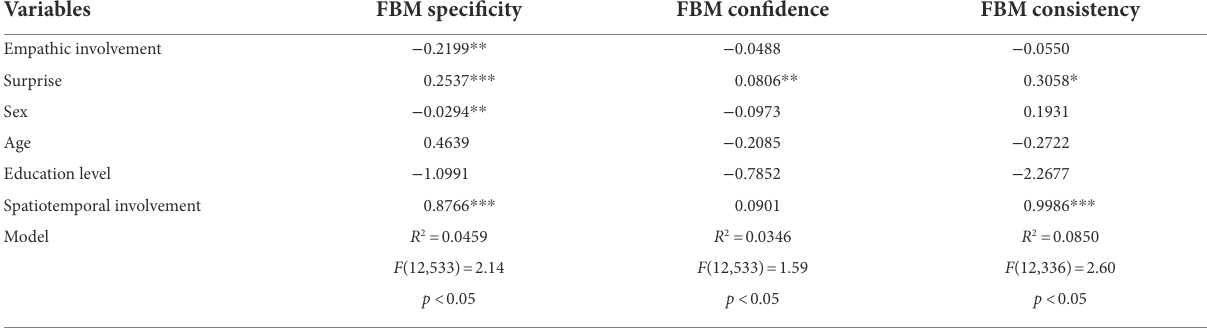
TABLE 4 Empathic involvement on FBM